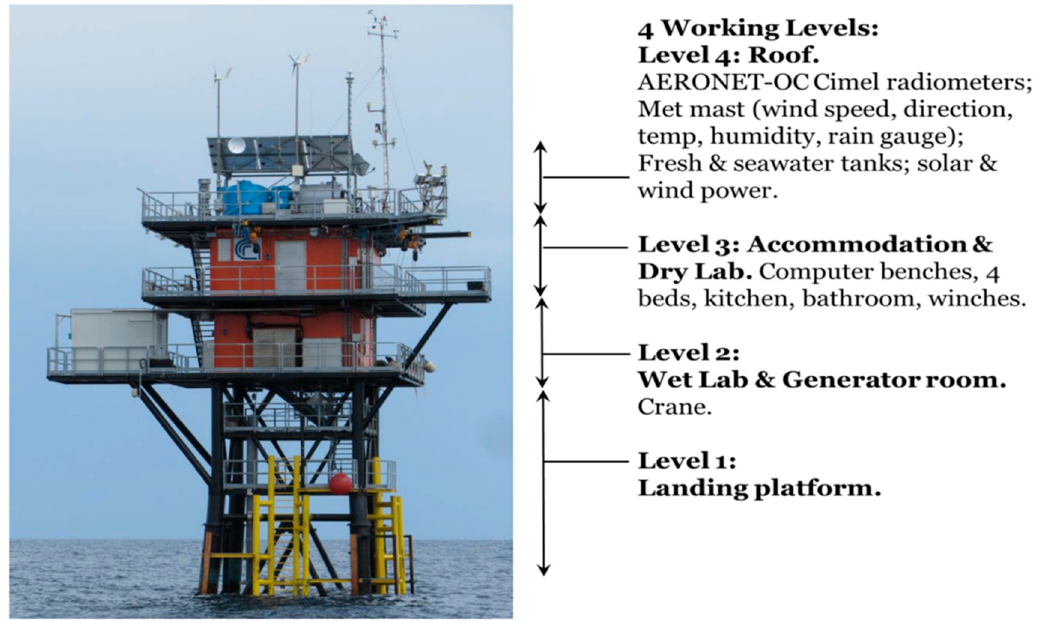
Figure 20. Layout of the Acqua Alta Oceanographic Tower (AAOT). Reproduced with permission from [54].